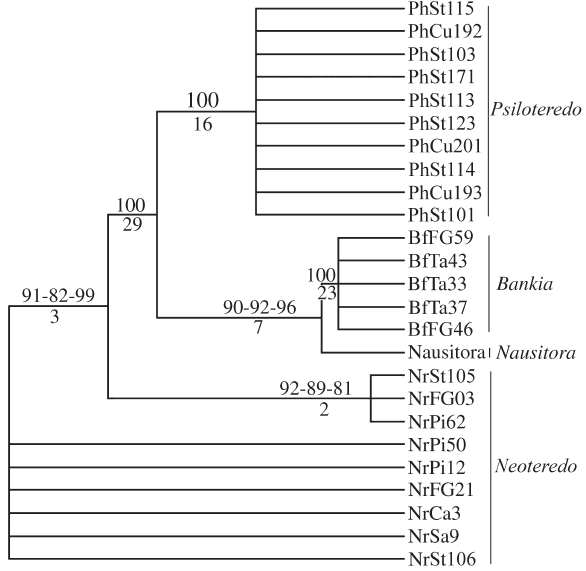
Figure 1 - Phylogenetic consensus tree obtained using maximum parsi- mony (MP), maximum likelihood (ML) and neighbor joining (NJ). Num- bers above the branches indicate the bootstrap values (MP (left), ML (center) and NJ (right)). A single number above the branches indicates that the three methods gave the same bootstrap value. Numbers below the branches show Bremer Decay indices. Species codes: Ph = Psiloteredo healdi ; Bf = Bankia fimbriatula ; Nr = Neoteredo reynei . Collection site codes:St=Salvaterra;Cu=Cumbu;FG=FuroGrande;Ta=Tamatateua; Ca = Canela Island; Sa = Salinópolis; Pi = São João de Pirabas.